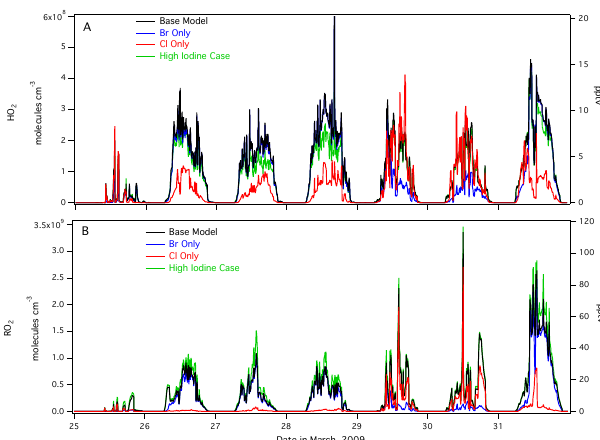
Figure 9. Comparison of modeled HO 2 (a) and RO 2 (b) from four different modeling scenarios: Base (Br and Cl present; black trace), Br Only (blue trace), Cl Only (red trace), and Base + High Iodine (green trace). RO 2 is defined here as the sum of the methyl through butyl forms of alkyl peroxy radicals. Time is expressed in Alaska Standard